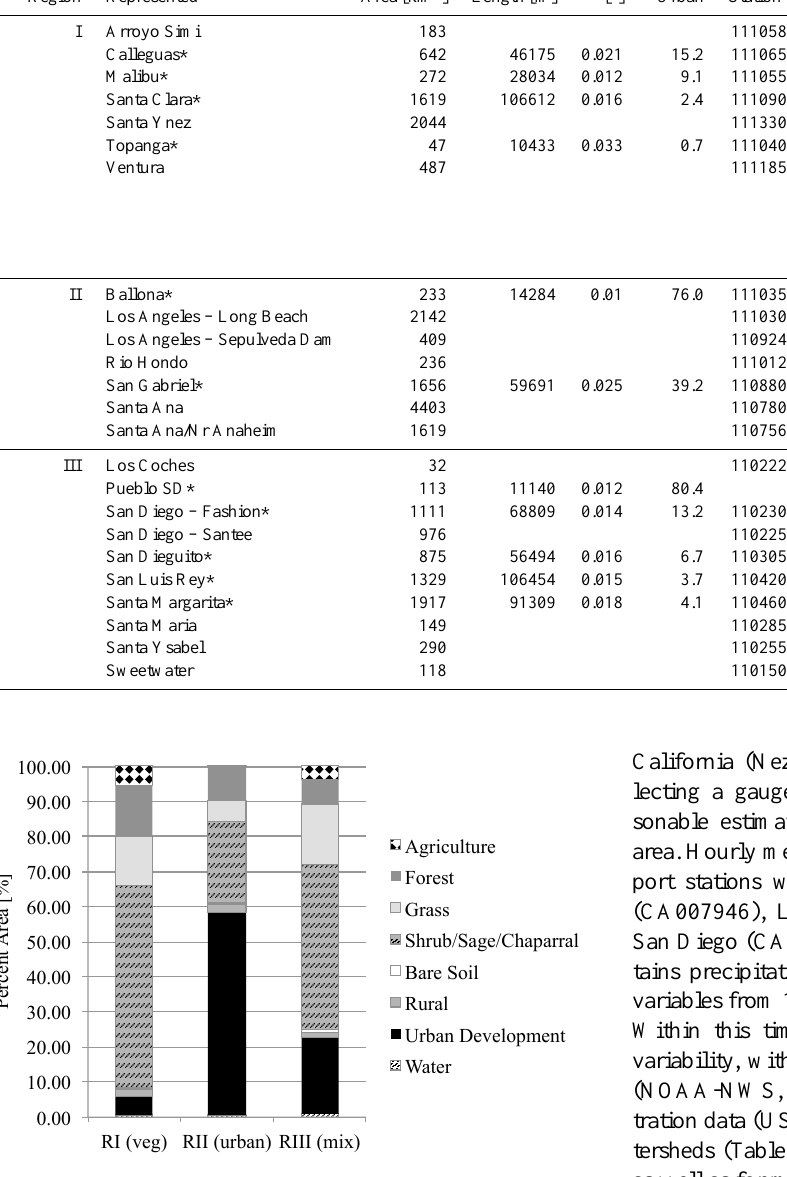
Fig. 1. Percent of total area of aggregated land cover distributions for Regions